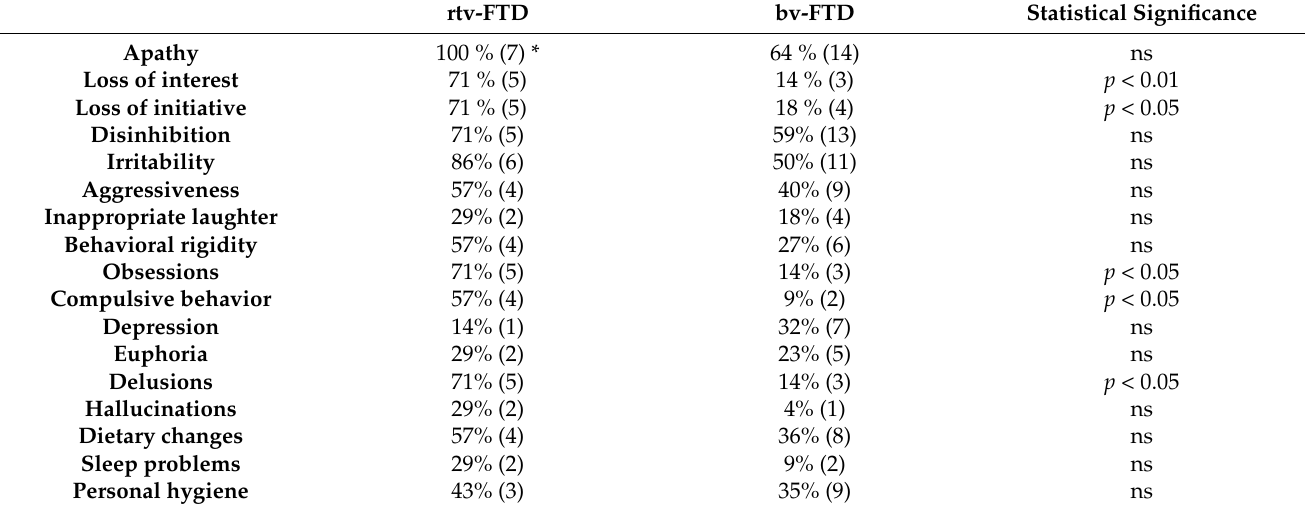
Table 4. Behavioral symptoms in right temporal variant FTD versus behavioral variant FTD patients in our initial evaluation. rtv-FTD